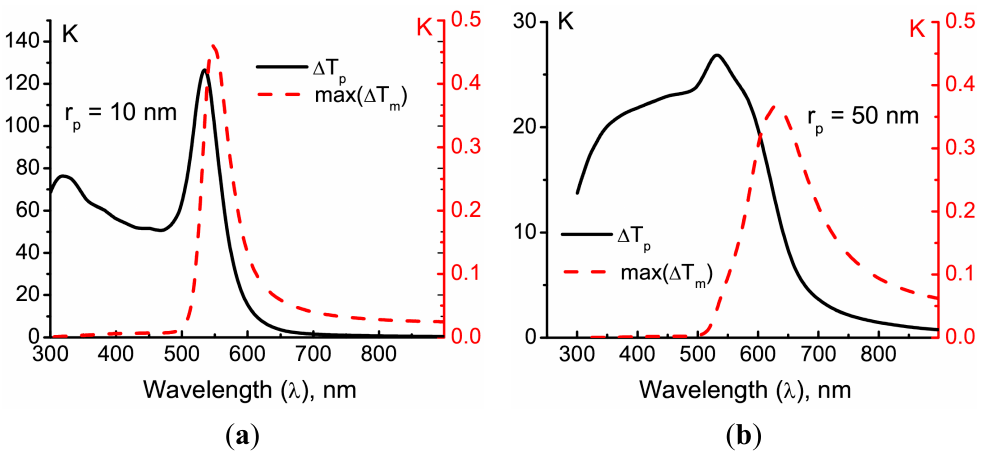
Figure 3. Temperature rise in the particle (black solid lines, left axis) and the temperature rise in the matrix due to the two-photon absorption (red dashed lines, right axis) after irradiation by a single laser pulse of duration τ pulse = 100 fs. The particle radius is either 10 nm ( a ) or 50 nm ( b ). The incident laser fluence is F 0 = 2 × 10 − 4 J/cm 2 , which corresponds to the maximum field intensity I 0 = 2 × 10 9 W/cm 2 . The incident polarization is circular. The volume-specific heat values for the particle and the matrix are C p ρ p = 2.5 J·cm − 3 K − 1 and C m ρ m = 1.7 J·cm − 3 K − 1 , respectively. The dependencies of n p (λ) and n m (λ) for gold and PMMA are taken from [15,16], respectively. For the two-photon absorption, σ m (2) = 100 GM, N m = 6 × 10 20 cm − 3 and η T = 1 are